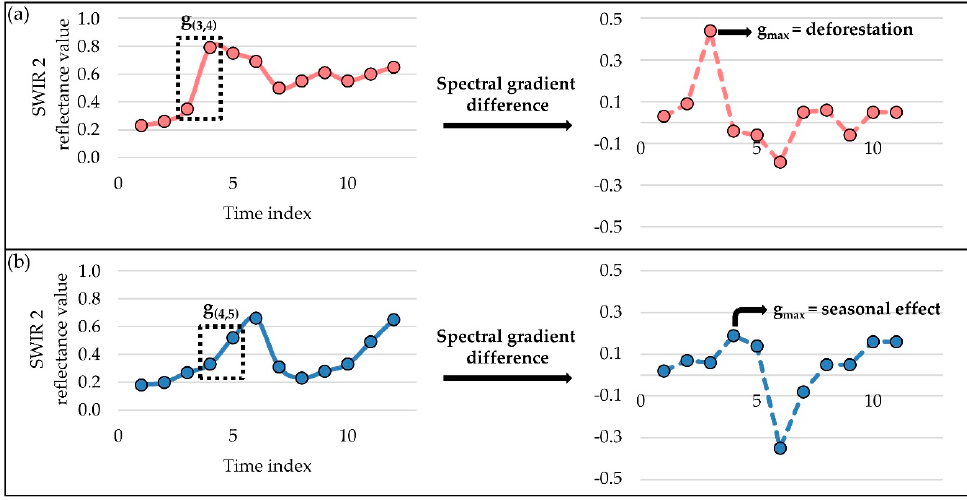
Figure 3. ( a ) Reflectance values, spectral gradient differences, and maximum g value of a Def object; and ( b ) of a Sch